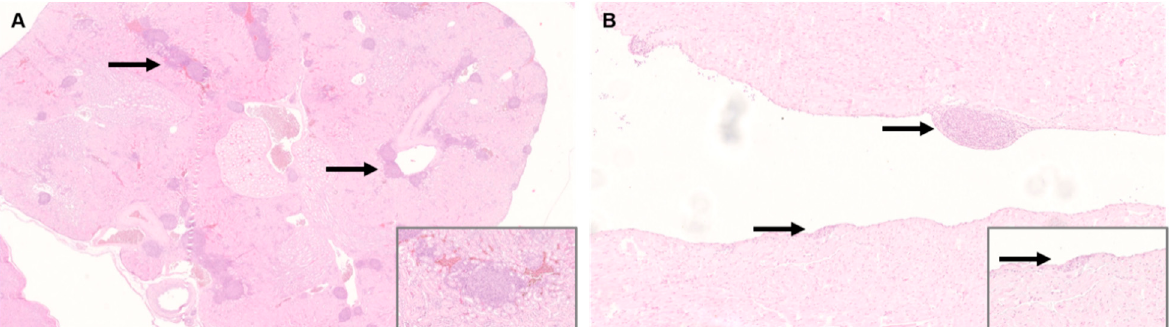
Figure 3. Histology of peripheral organs of Parrot bornavirus 4 (PaBV-4) infected juvenile cockatiels. ( A ) Kidney of juvenile cockatiel J 6. Severe non-purulent interstitial nephritis and lymphoid hyper- plasia; original magnification ×25, magnification of insert ×200. ( B ) Heart of juvenile cockatiel J 1. Severe subendocardial ganglioneuritis (arrow); original magnification x100, magnification of insert x400; hematoxylin and eosin staining (H&E).